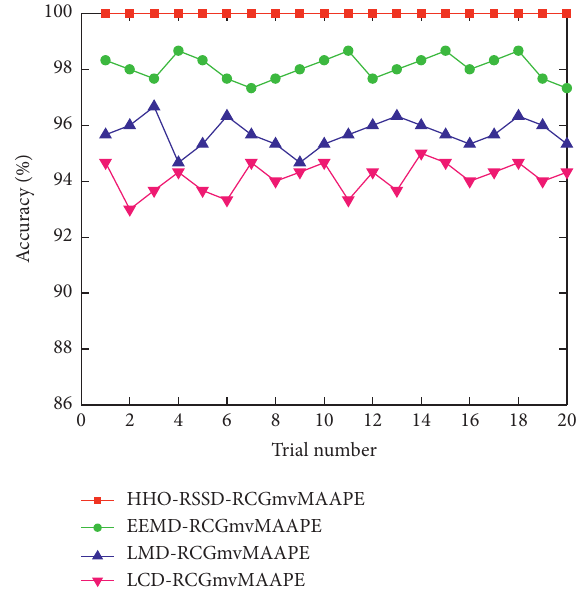
Figure 15: The diagnostic result of four signal decomposition